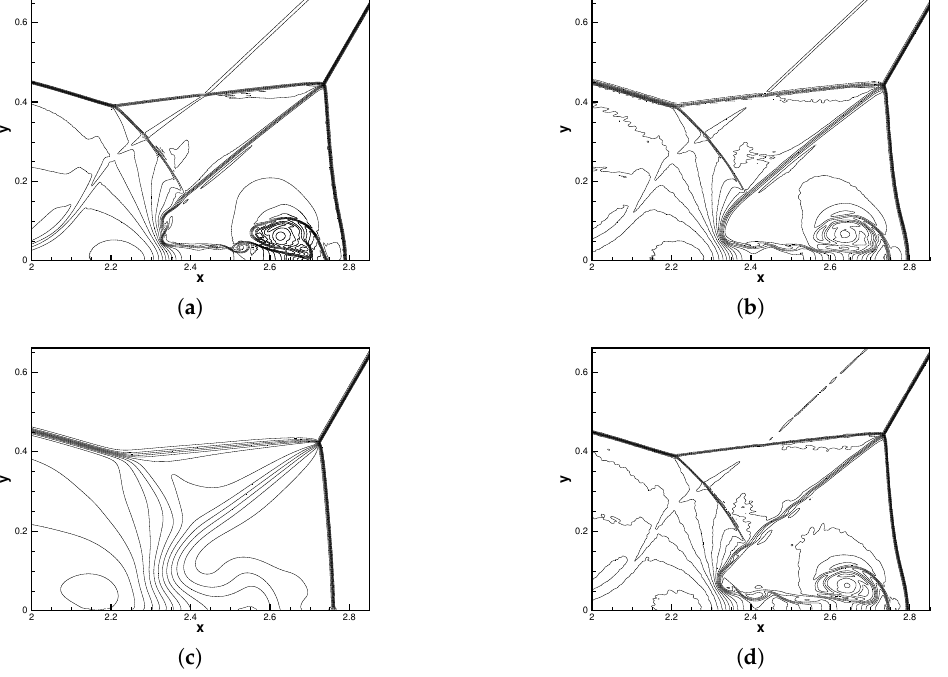
Figure 21. Density solution for the double Mach problem with 816 × 204 P 2 elements at t = 0.2. Thirty-three equally spaced contours from 1.75 to 22.7. ( a ) DB; ( b ) MDH; ( c ) MDA; ( d ) MDAEX.